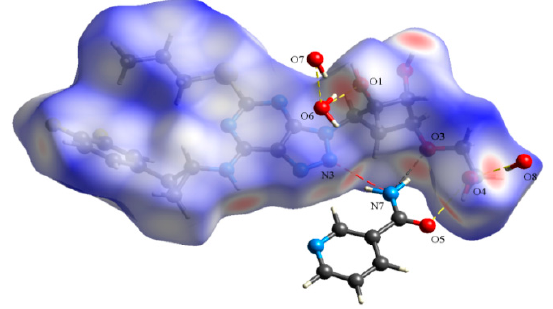
Figure 5. Representative Hirshfeld surface of TICA-NCA hydrate.